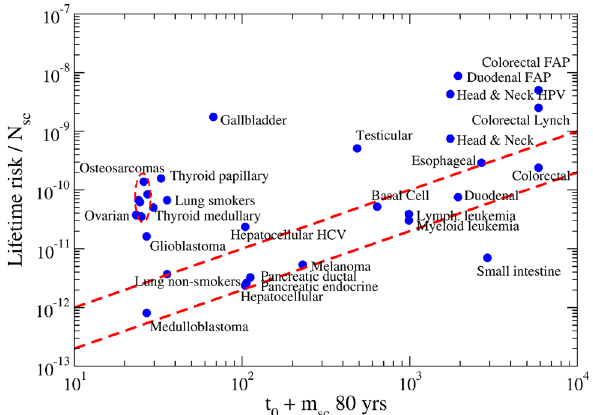
Figure 5. Lifetime risk of cancer per stem cell in a tissue vs the number of stem cell generations. The analysis is based on Eq. (12). The band delimited by the red dashed lines contains the group of tissues qualified as normal. See detailed explanations in the main